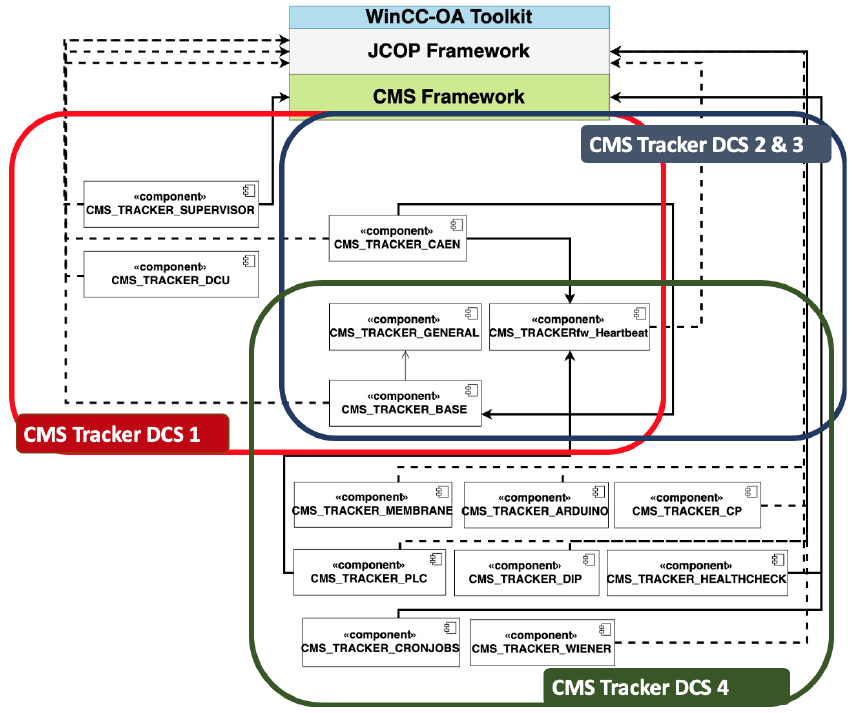
Fig. 4. TCS component